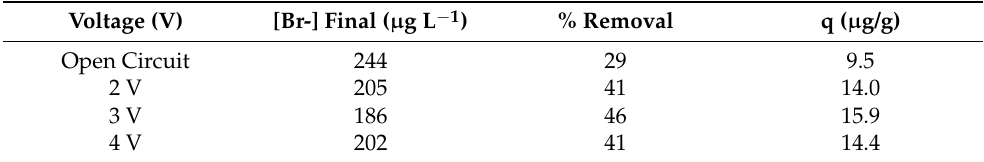
Table 3. Bromide concentration at the end of the experiment, % removal and amount adsorbed at the equilibrium on activated carbon in different electroadsorption experiments at different